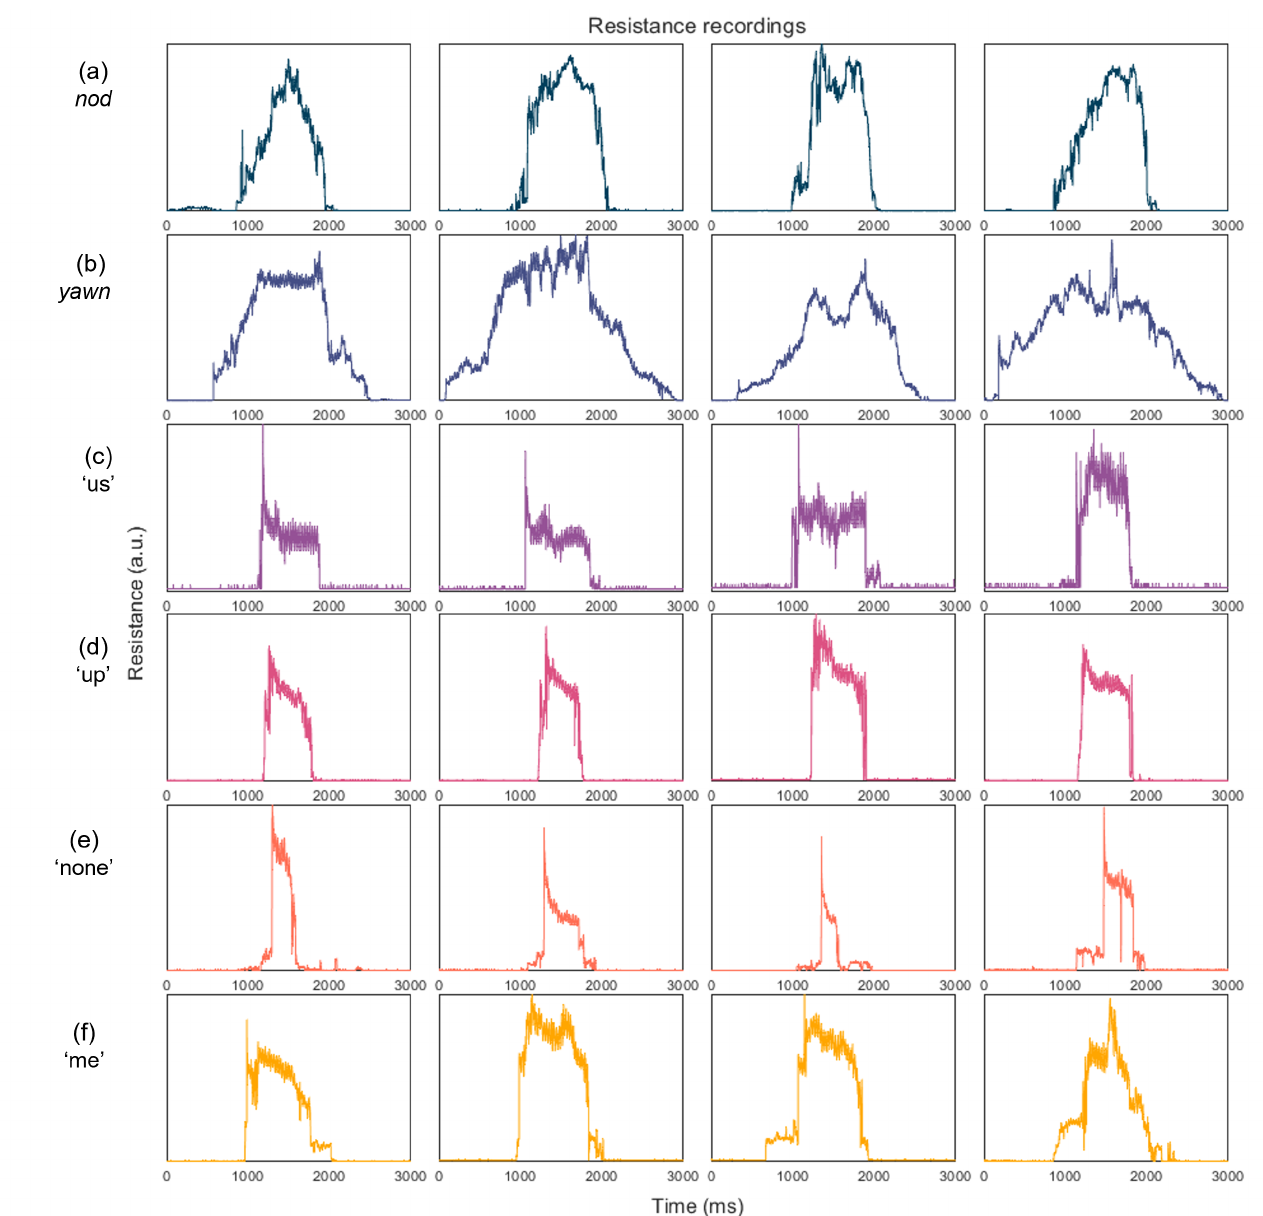
Figure 5. Examples of resistance readings of ( a ) nod , ( b ) yawn , ( c ) ’us’, ( d ) ’up’, ( e ) ’none’, ( f )